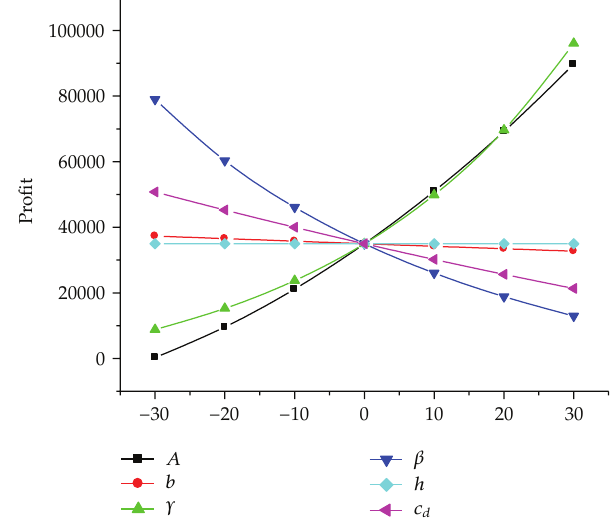
Figure 2: Behavior of distributor’s profit functions with respect to percentage of change in parameters